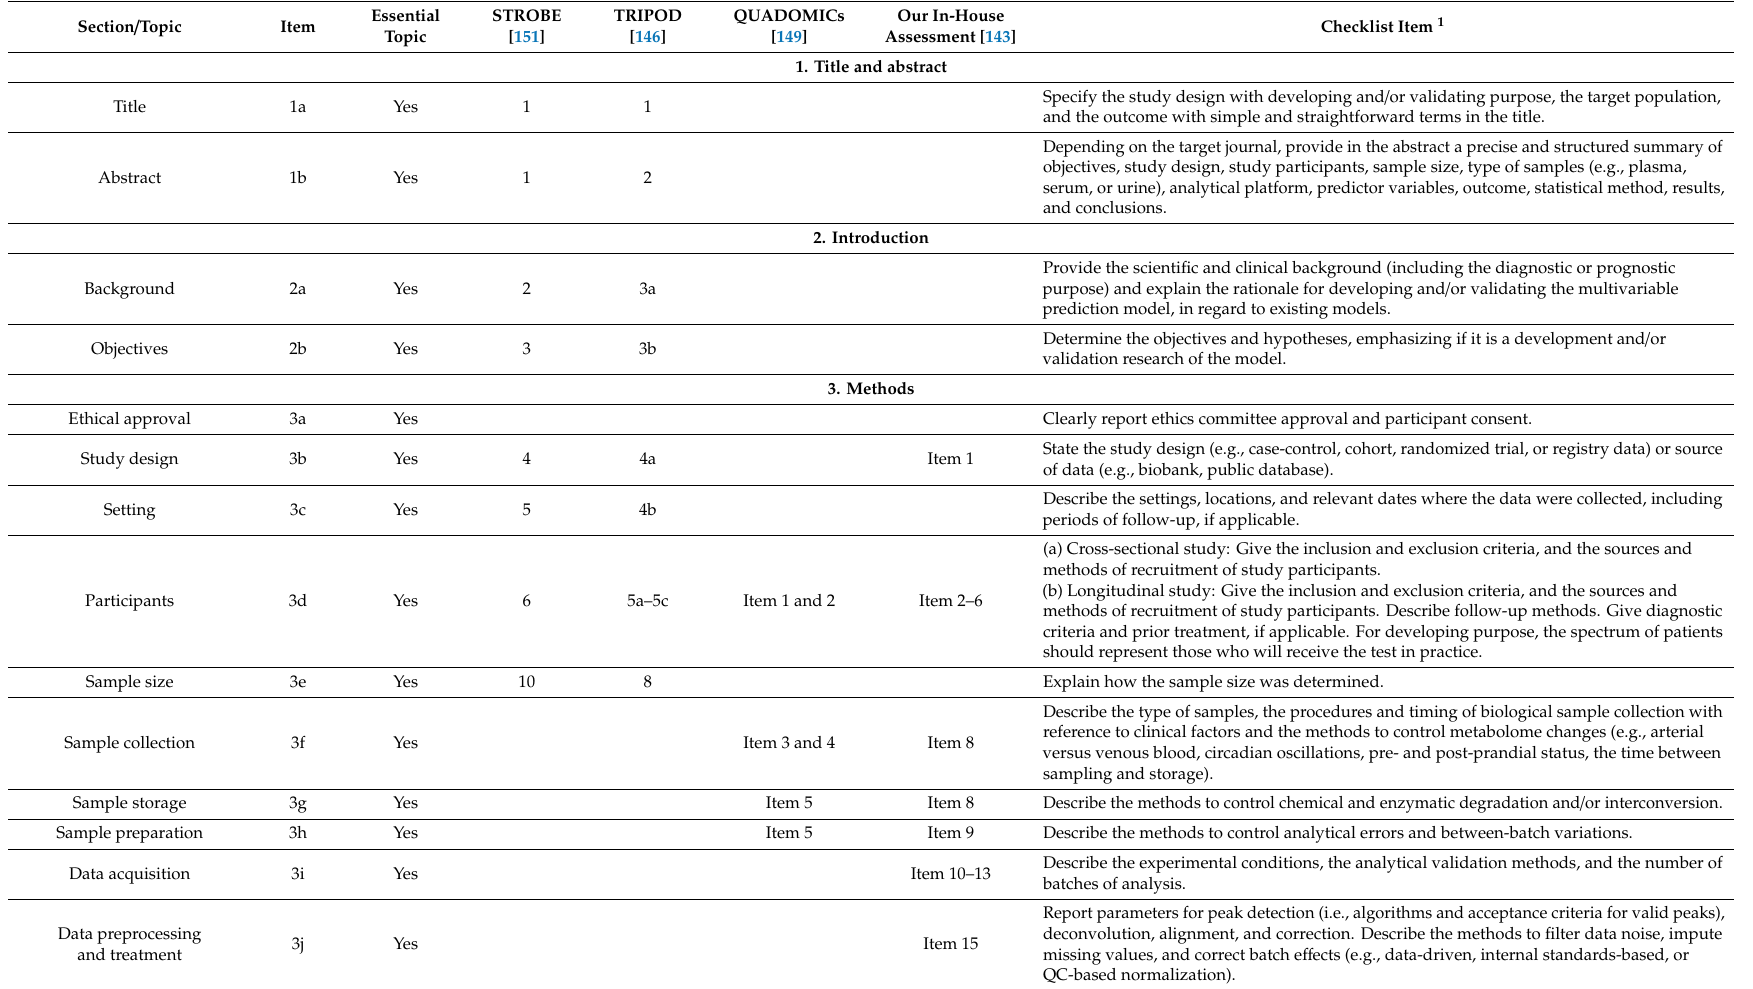
Table 3. Proposed checklist for clinical metabolomics-based biomarker discovery and validation in reference to STROBE, TRIPOD, and